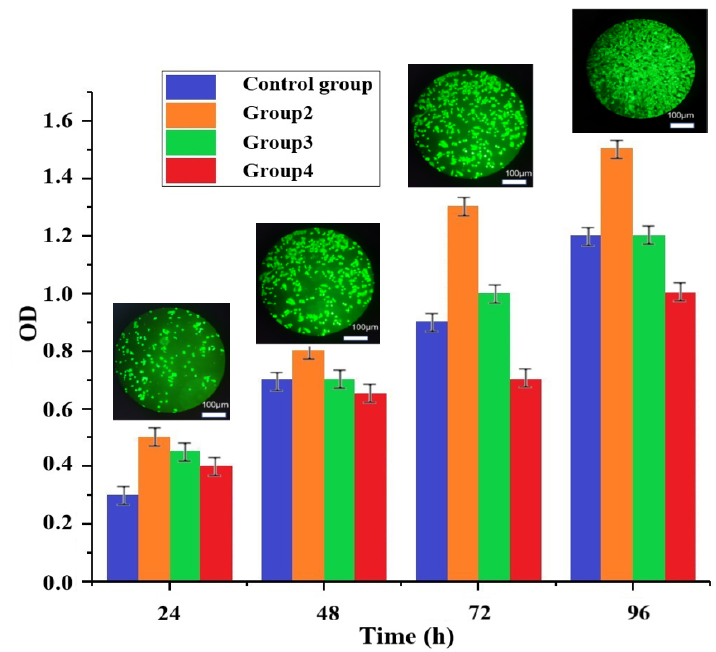
Figure 15. Cell activity observation graph (insert graph is group